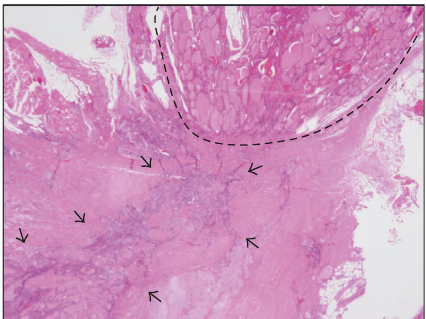
Figure 4: Histopathology of Section A in Figure 3. Clear de- marcation is evident between the thyroid tissue and tumor. Dotted line delineates normal thyroid tissue truncating at the isthmus. Arrowheads point to the tumor site. Hematoxylin and eosin staining, × 1.25.